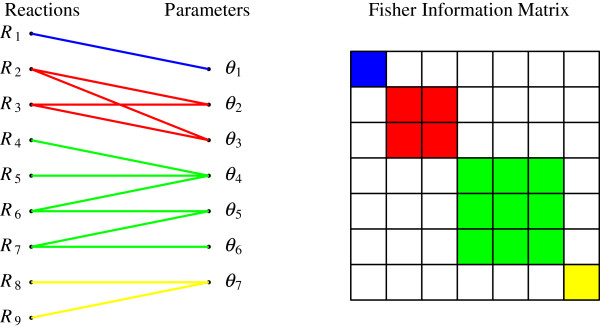
The graph representation (left panel) of the dependencies between the reactions (left column) and the model parameters (right column) as well as the corresponding block-diagonal structure of the FIM (right panel). The grouping of the parameters is carried out by noting the connected parts of the graph. In this example K = 7 while the largest dimension of the blocks is L = 3.